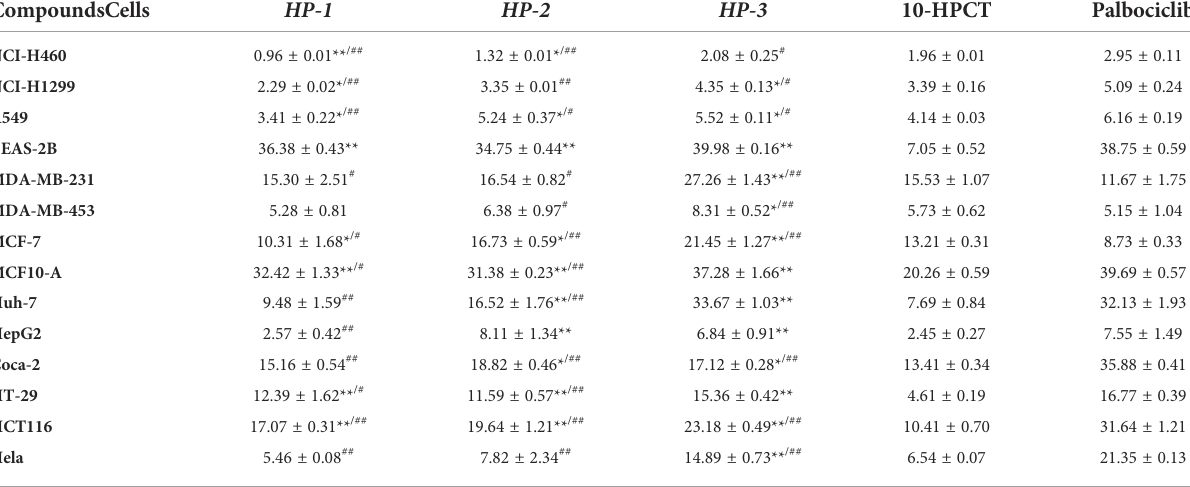
TABLE 2 IC 50 value of compounds HP-1 , HP-2 , and HP-3 .